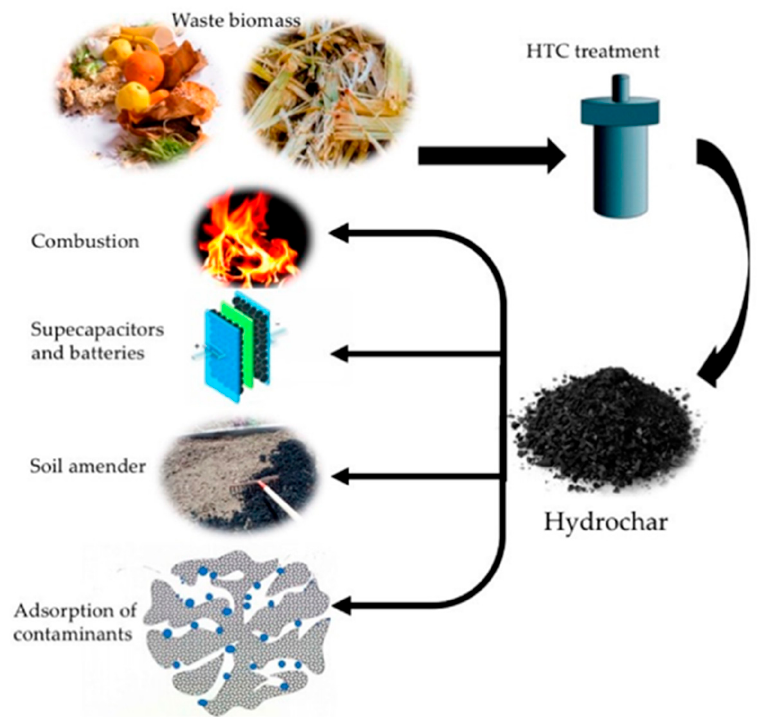
Figure 2. The potential applications of waste biomass. Reprinted with permission from Ref. [22].